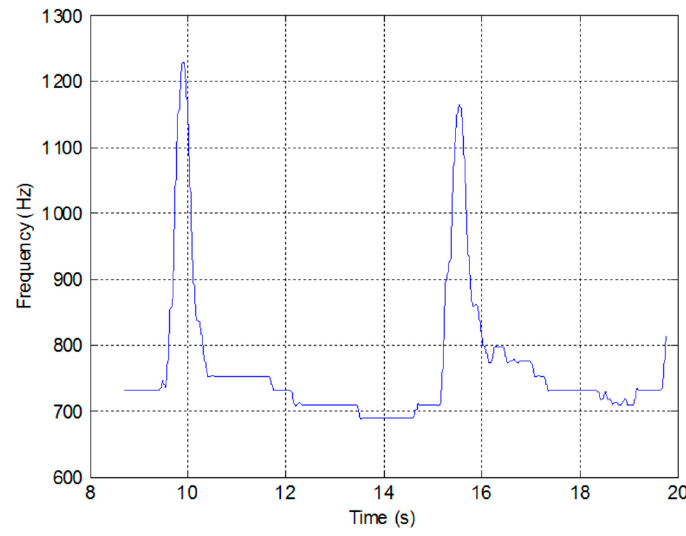
Figure 19. Signal frequency extracted from spectrogram.